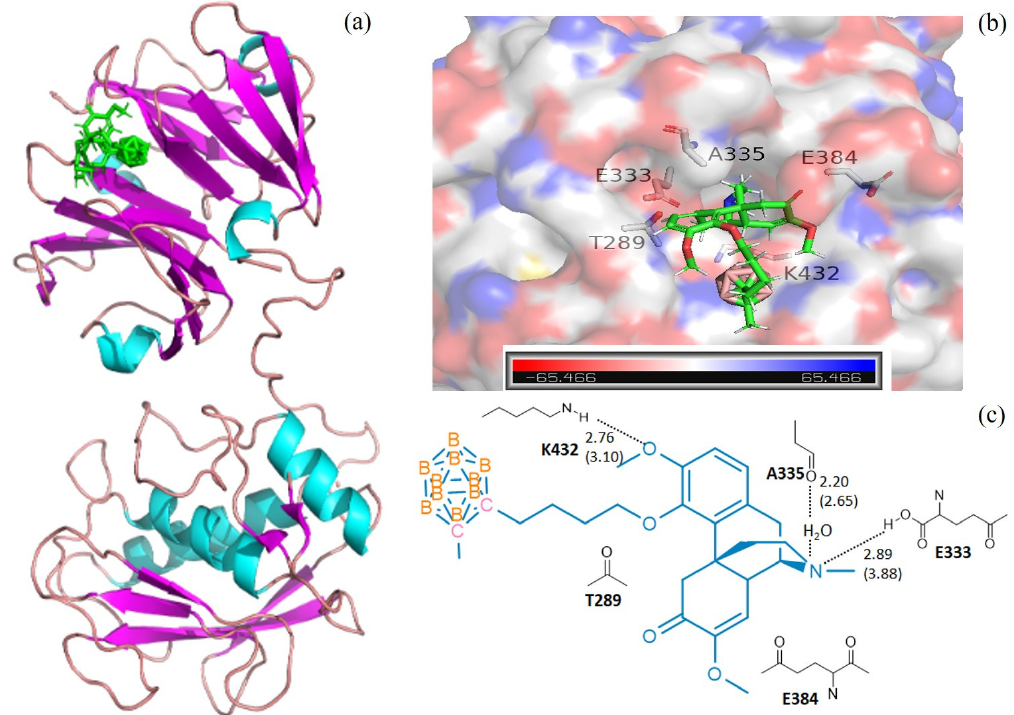
Figure 1. The docking models for 3 with collagenases MMP1-1FBL. ( a ) domain structures of the interaction of 3 (green) and MMP1-1FBL (ribbon diagram illustrating). The figure was generated using the pymol 2.4 software; ( b ) MMP1-1FBL active site pocket with bound moiety of 3 . The collagenase surface is colored by electrostatic potential; blue for positive and red for negative. The figure was generated using the pymol 2.4 software; ( c ) interactions (hydrogen bonds) of amino acid residues with 3 . The figure was generated using Chemdraw 10.0 and pymol 2.4 software.